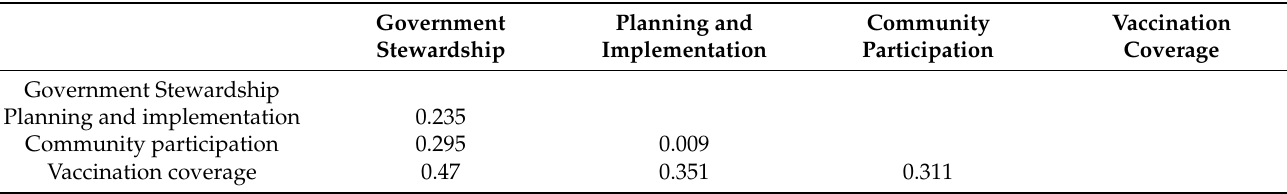
Table 6. Discriminant validity assessment using the HTMT test.